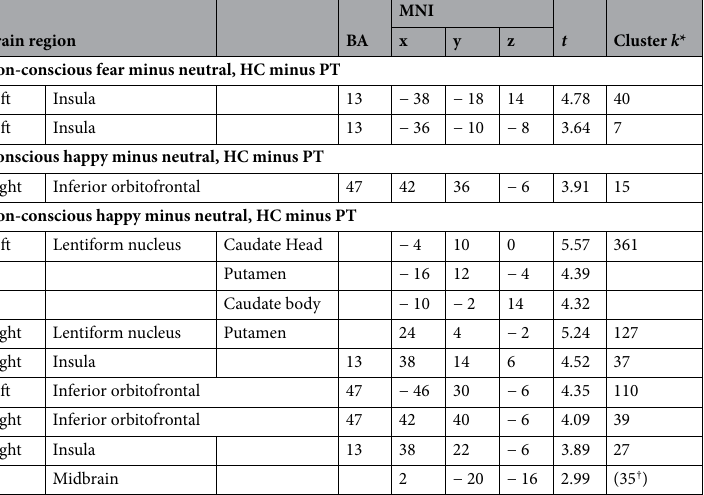
Table 2. Brain regions with statistically significant differences in activation between insomniacs and healthy controls (p < 0.05, small volume correction). BA Brodmann area, MNI Montreal Neurological